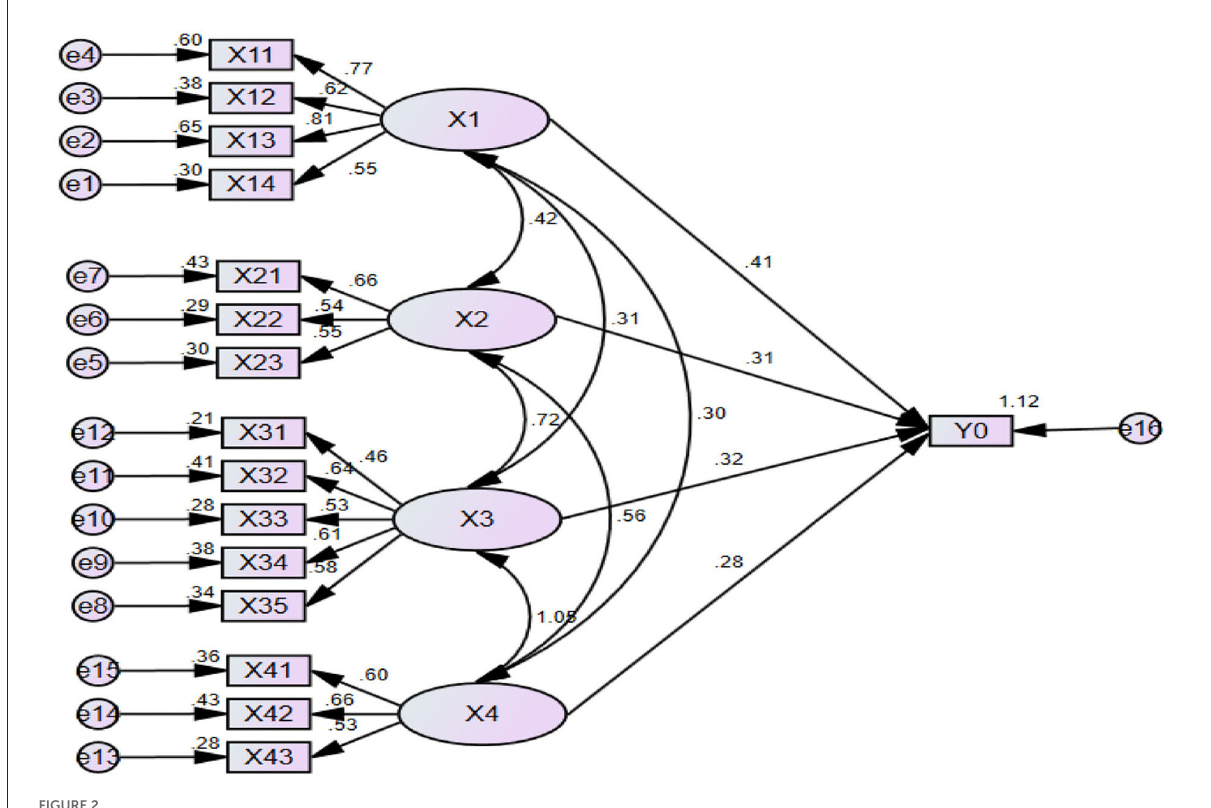
FIGURE2 Structural equation model.